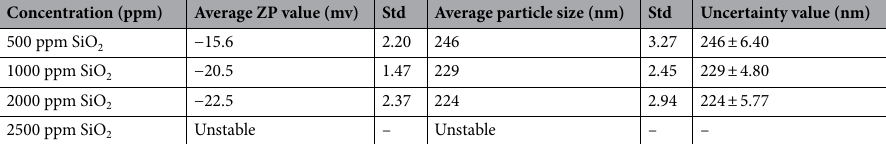
Table 15. ZP and DLS results of OLSHW with uncertainty in the presence of divalent ions with various NPs concentrations at pH 5.